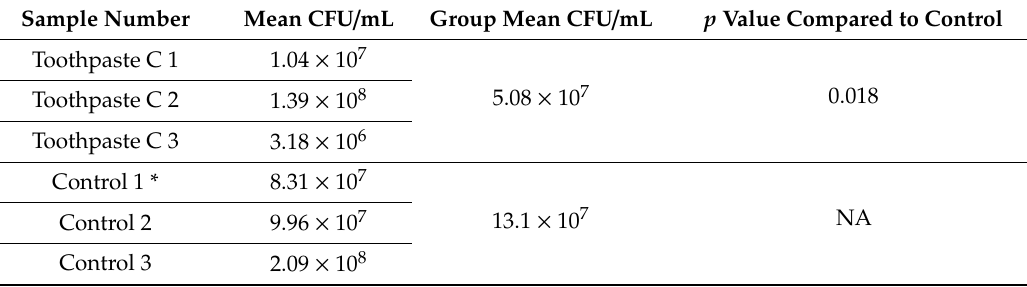
Table 3. Regrowth of polymicrobial oral biofilm. CFU = colony forming